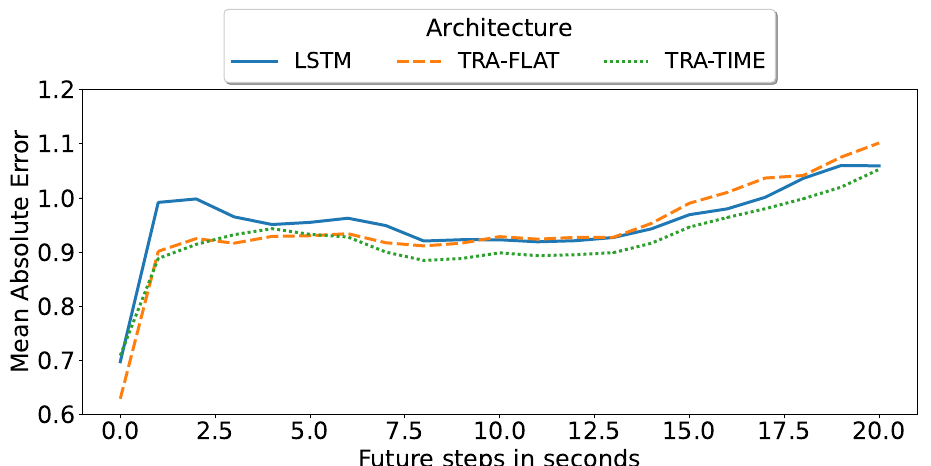
Figure 6. Comparison of MAE values across steps in the forecasting horizon. The horizontal axis represents the second of each step and the vertical axis represents the MAE. The best performing architecture for multi-horizon forecasting was TRA-TIME with an average MAE of 0.918, followed by TRA-FLAT with an average MAE of 0.939, and finally LSTM with an average MAE of 0.951. The figure clearly demonstrates that the LSTM model outperformed the TRA-FLAT after the tenth prediction second, which is significant as a fully loaded AGV requires at least 10 s to